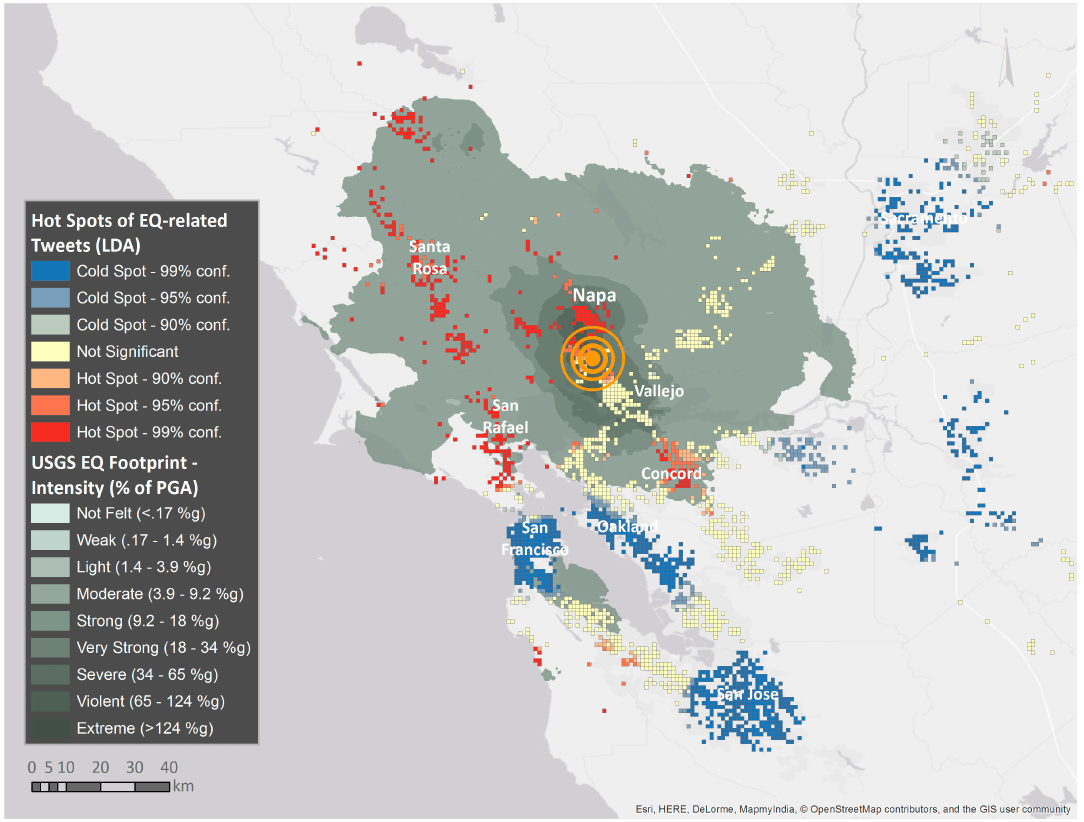
Figure 7. Earthquake Footprint as Identified by Analysing Social Media Posts [74].